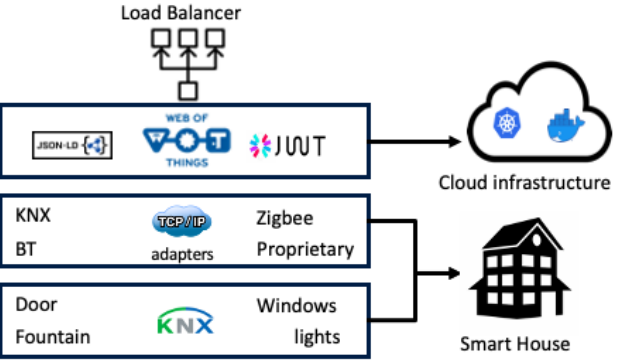
Figure 3. Three layer Architecture